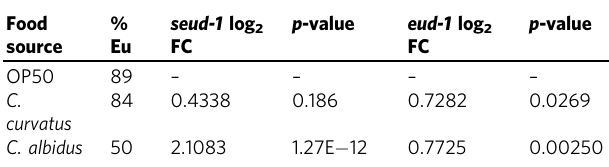
Log fold change (log 2 FC) of seud-1 and eud-1 is shown for Pristionchus paci fi cus (strain PS312) grown under different morph-inducing environments ( Cryptococcus yeast species offered as food) comparedtoa diet E. coli OP50.% Euis the median proportion of the eurystomatous (Eu) morph out of total individuals screened, as previously reported on those diets 22 . p- values were obtained using an exact test with a Benjamini – Hochberg correction for multiple Cryptococcus albicus yeasts resulted in higher enrichment of seud- 1 expression compared with a diet of E. coli OP50 (Table 1). In contrast, a relatively Eu-inducing diet of C. curvatus yeasts